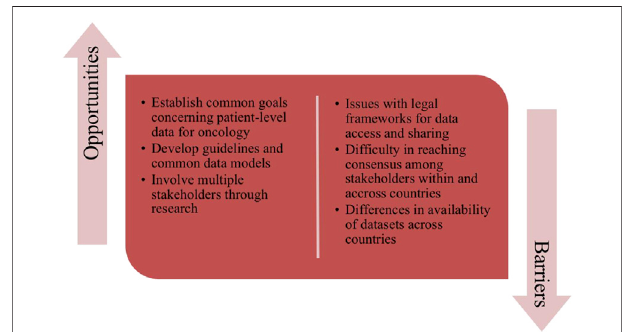
FIGURE 6 | Key opportunities and barriers outlined by the participants for cross-country collaborations to improve data collection systems for oncology across